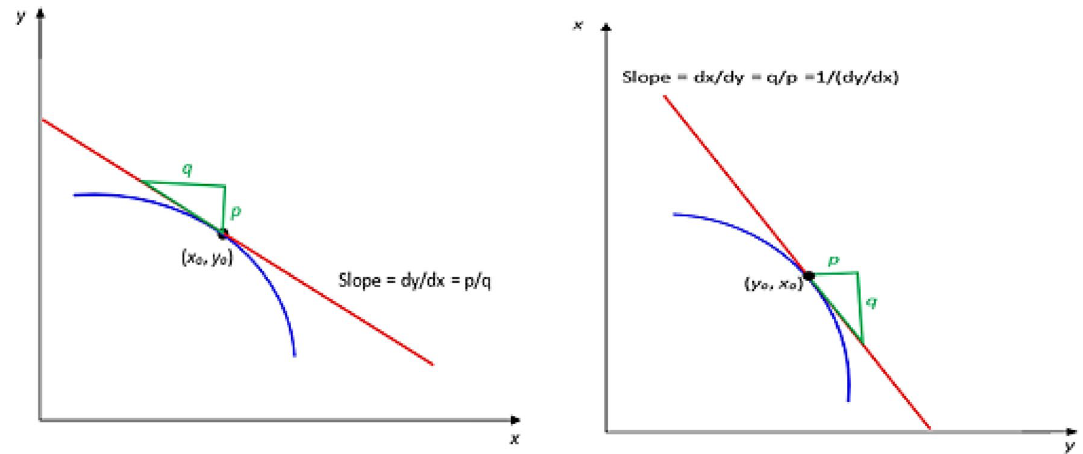
Fig. 18 Schematics of slopes at arbitrary points ( x